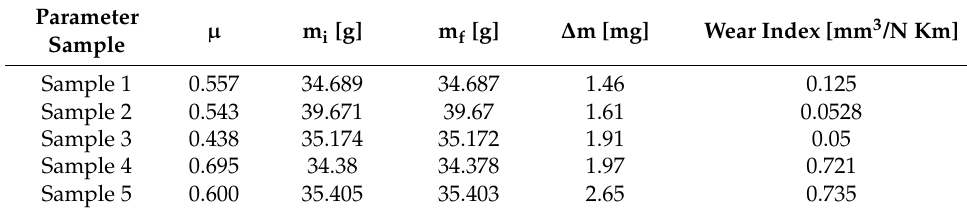
Figure 8. Back scattered electron micrograph of WC-Co/NiCrBSi wear scars after POD test ( a ); micro-ploughing – abrasive grooves (1), tribo-oxidation – migration of debris ( b ) along the surface (2), and EDX ( c ) spectra of debris agglomeration.